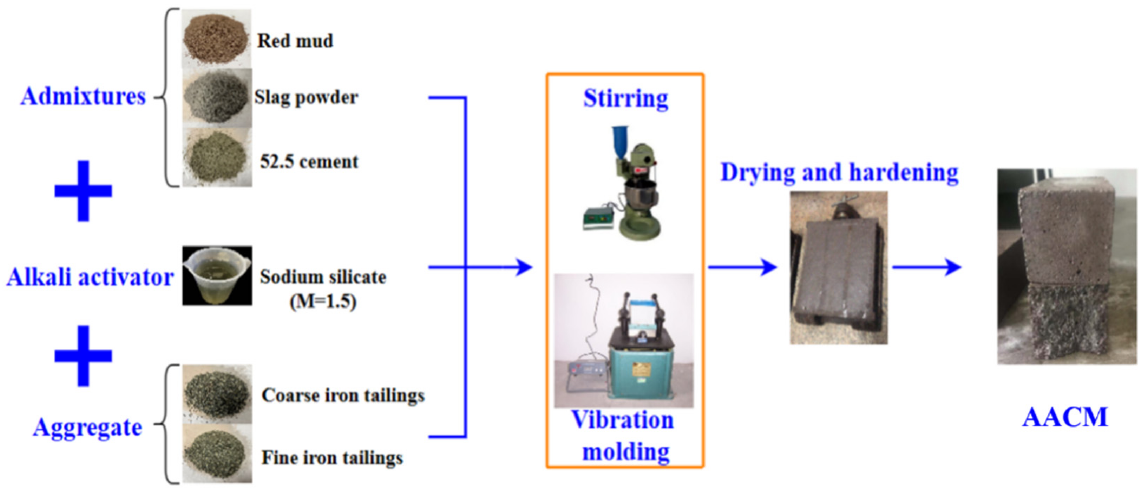
Figure 3. Preparation flow chart of AACM.